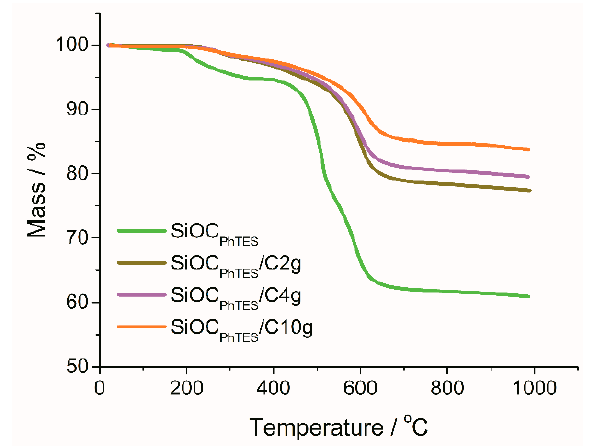
Figure 1. Dependence of the mass yield on the temperature of the SiOC/graphite composites.